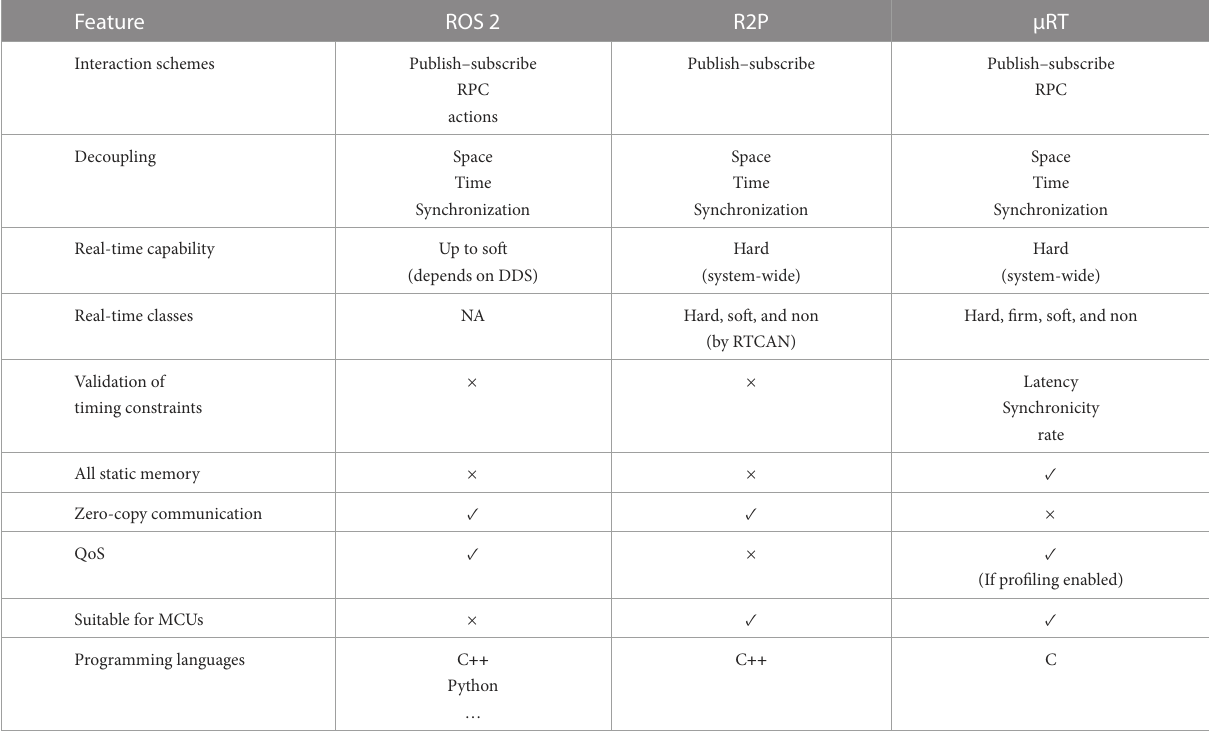
TABLE1 FeaturecomparisonofµRT,R2P(Migliavacca,2013),andROS2(Macenski et al.,2022).